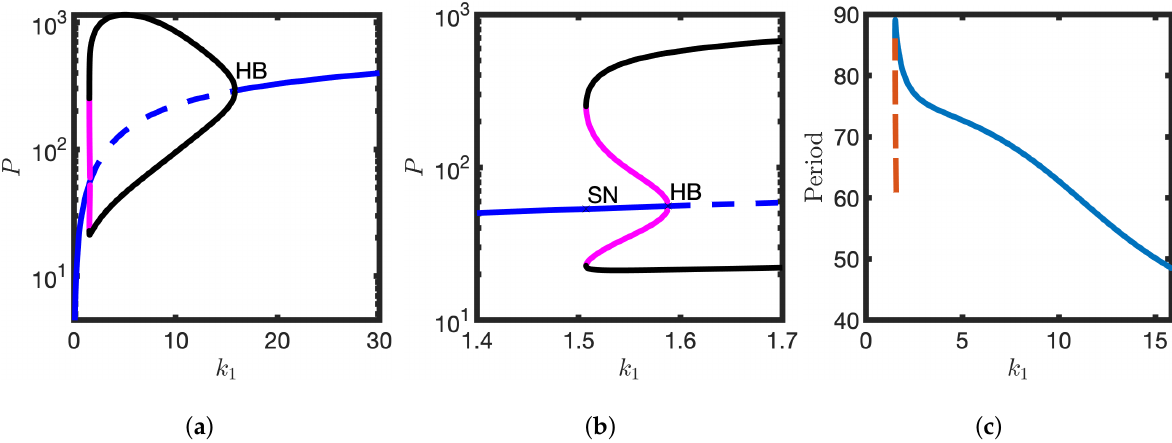
Figure 6. Bifurcation structure of Equation (2) upon varying the parameter k 1 . ( a ) Number of protein molecules is plotted against k 1 . Extrema of the stable (black line) and unstable (magenta line) limit cycles. Stable steady state (solid blue lines). Unstable steady state (dashed blue line). ( b ) Inset for ( a ). ( c ) Oscillator period is plotted against k 1 . Stable limit cycle (solid line), unstable limit cycle (dashed line). Hopf bifurcation (HB), Saddle node bifurcation (SN). Other parameter values as